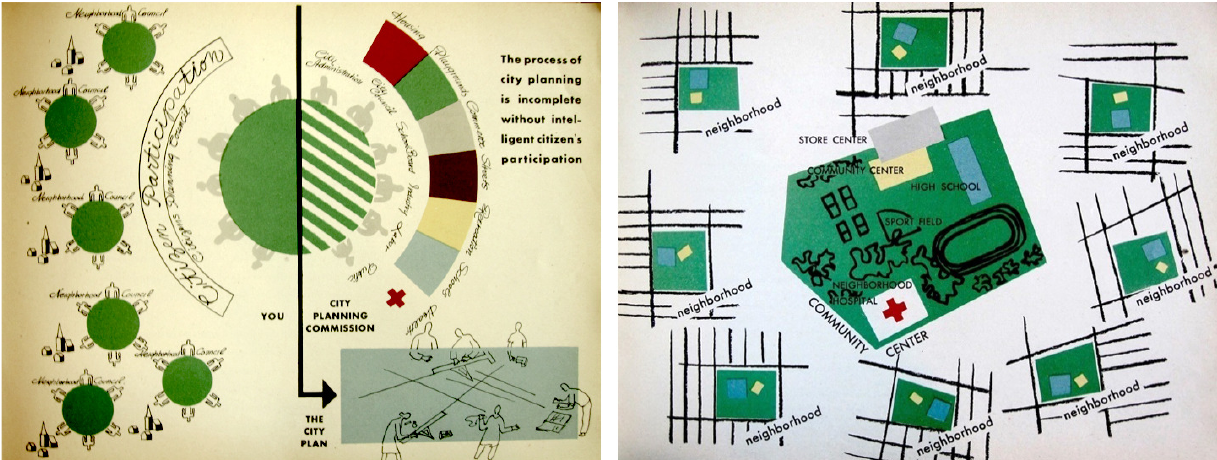
Figure 4. Schemes from You and Your Neighborhood . Source: Stonorov and Kahn